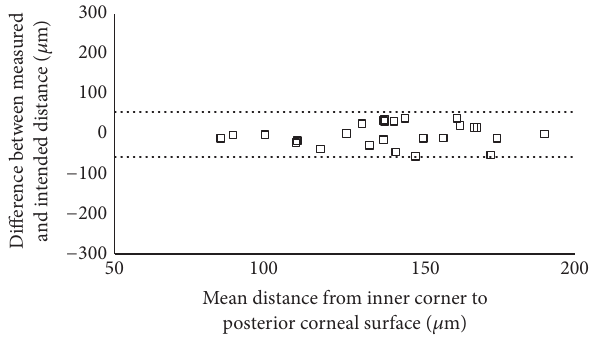
Figure 6: Scatterplot showing the differences between the measured and the intended distance from the Keraring inner corner to the posterior corneal surface. Individual differences between the measured and the intended distance are plotted against the mean value of the measured and the intended distance. The 95% LoA interval is represented with dotted lines.